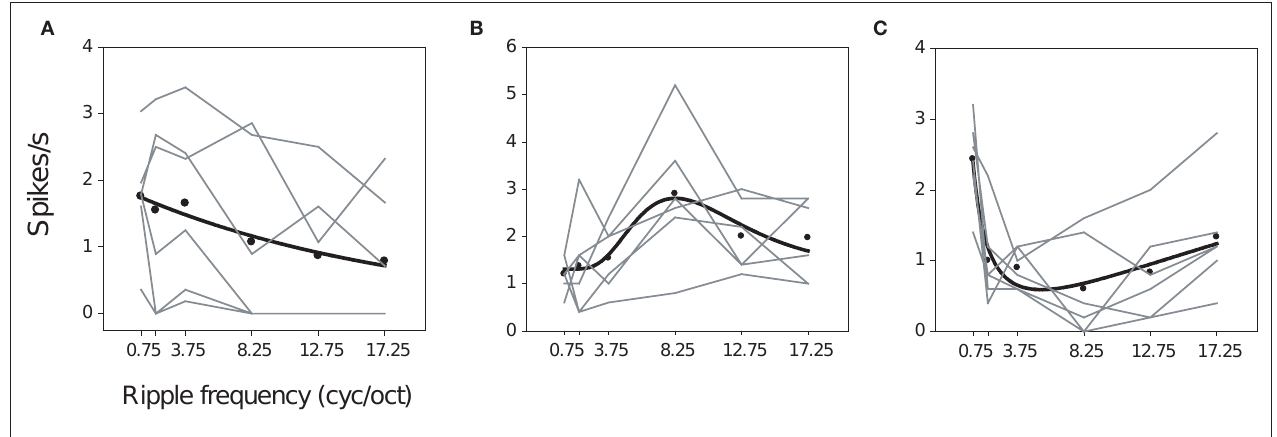
FiGure 4 | ripple frequency tuning. Examples of (A) low-pass, (B) band-pass, and (C) band-reject neurons. The — represent fits to spike rates averaged over bandwidth A : exponential decay, y =